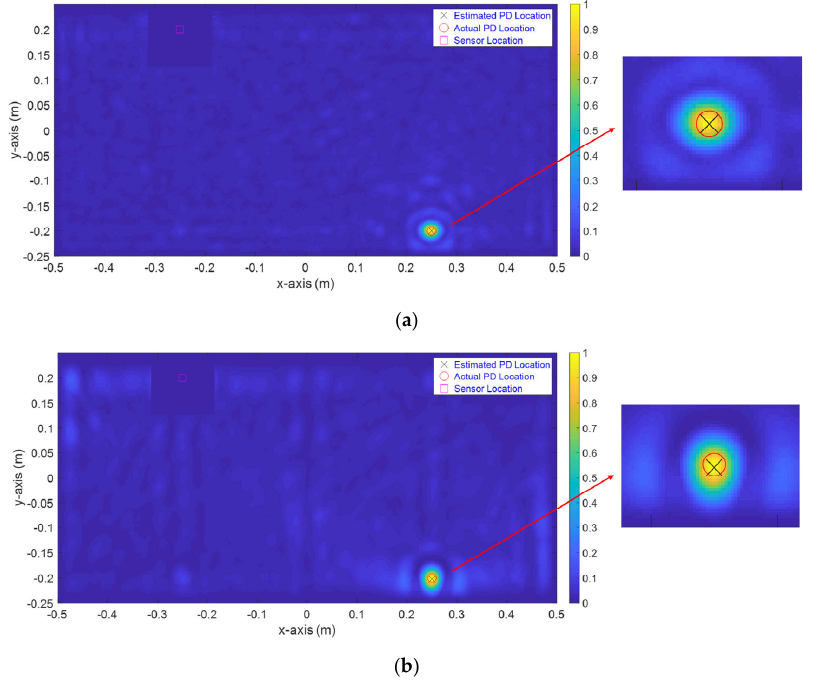
Figure 5. The distribution of the normalized maximum electric field power over the whole time interval in the computational domain, ( a ) obtained by the EMIF method and ( b ) obtained by the EMTR method. The localization errors are 0 for EMIF and 25 mm for